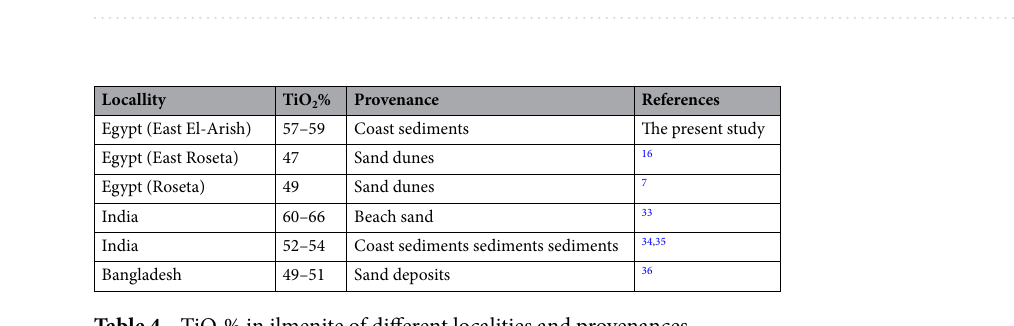
Table 3. comparison between the important parameters of various Egyptian black sand localities.